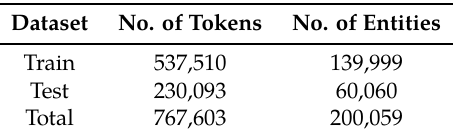
Table 1. Size of the data set.